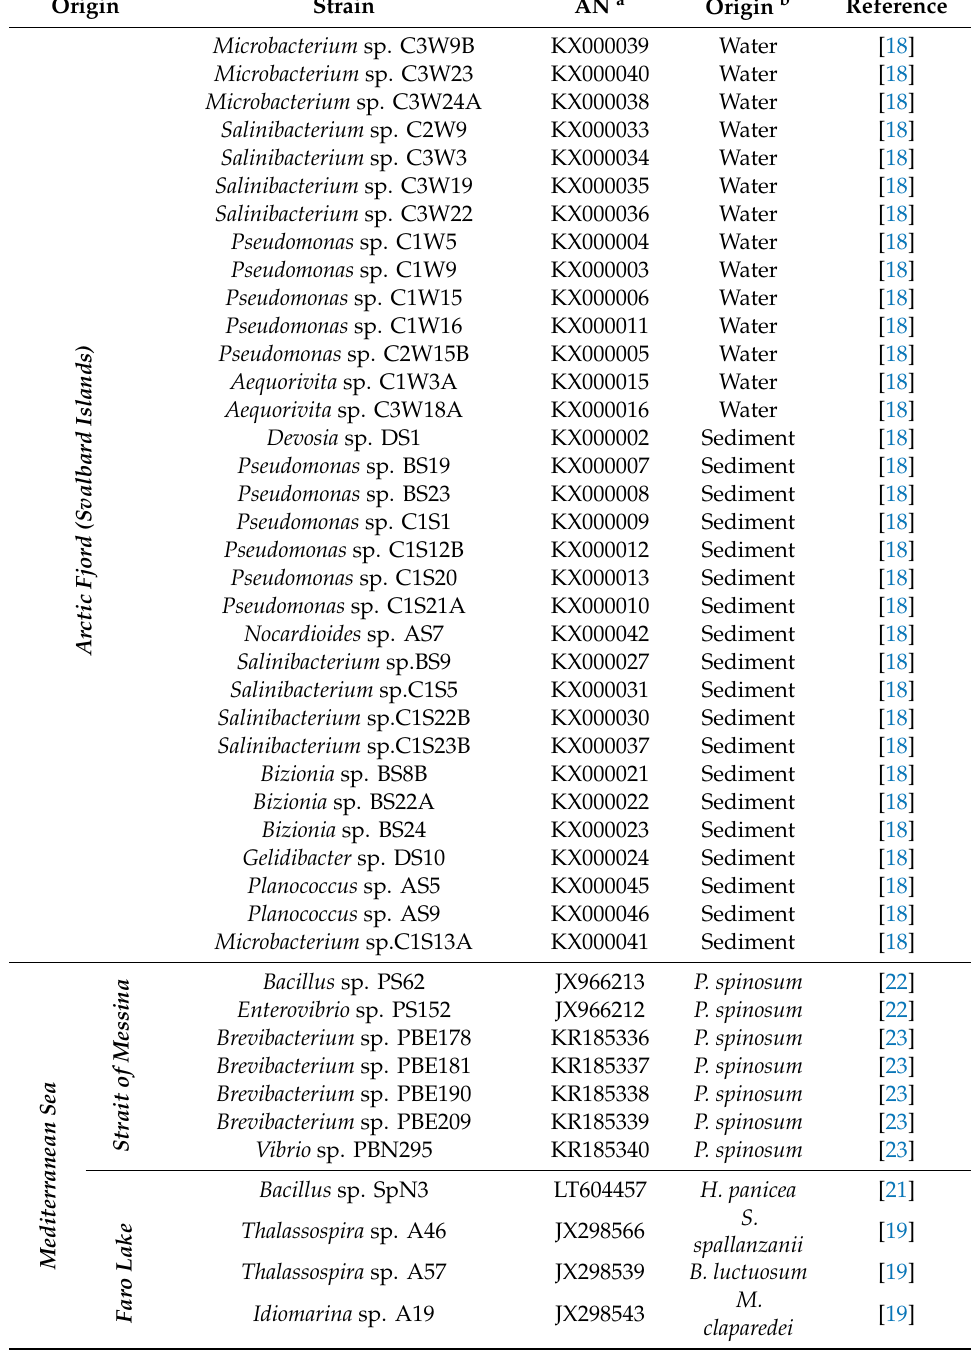
Table 1. List of Arctic and Mediterranean strains screened for inhibitory activity in this study.